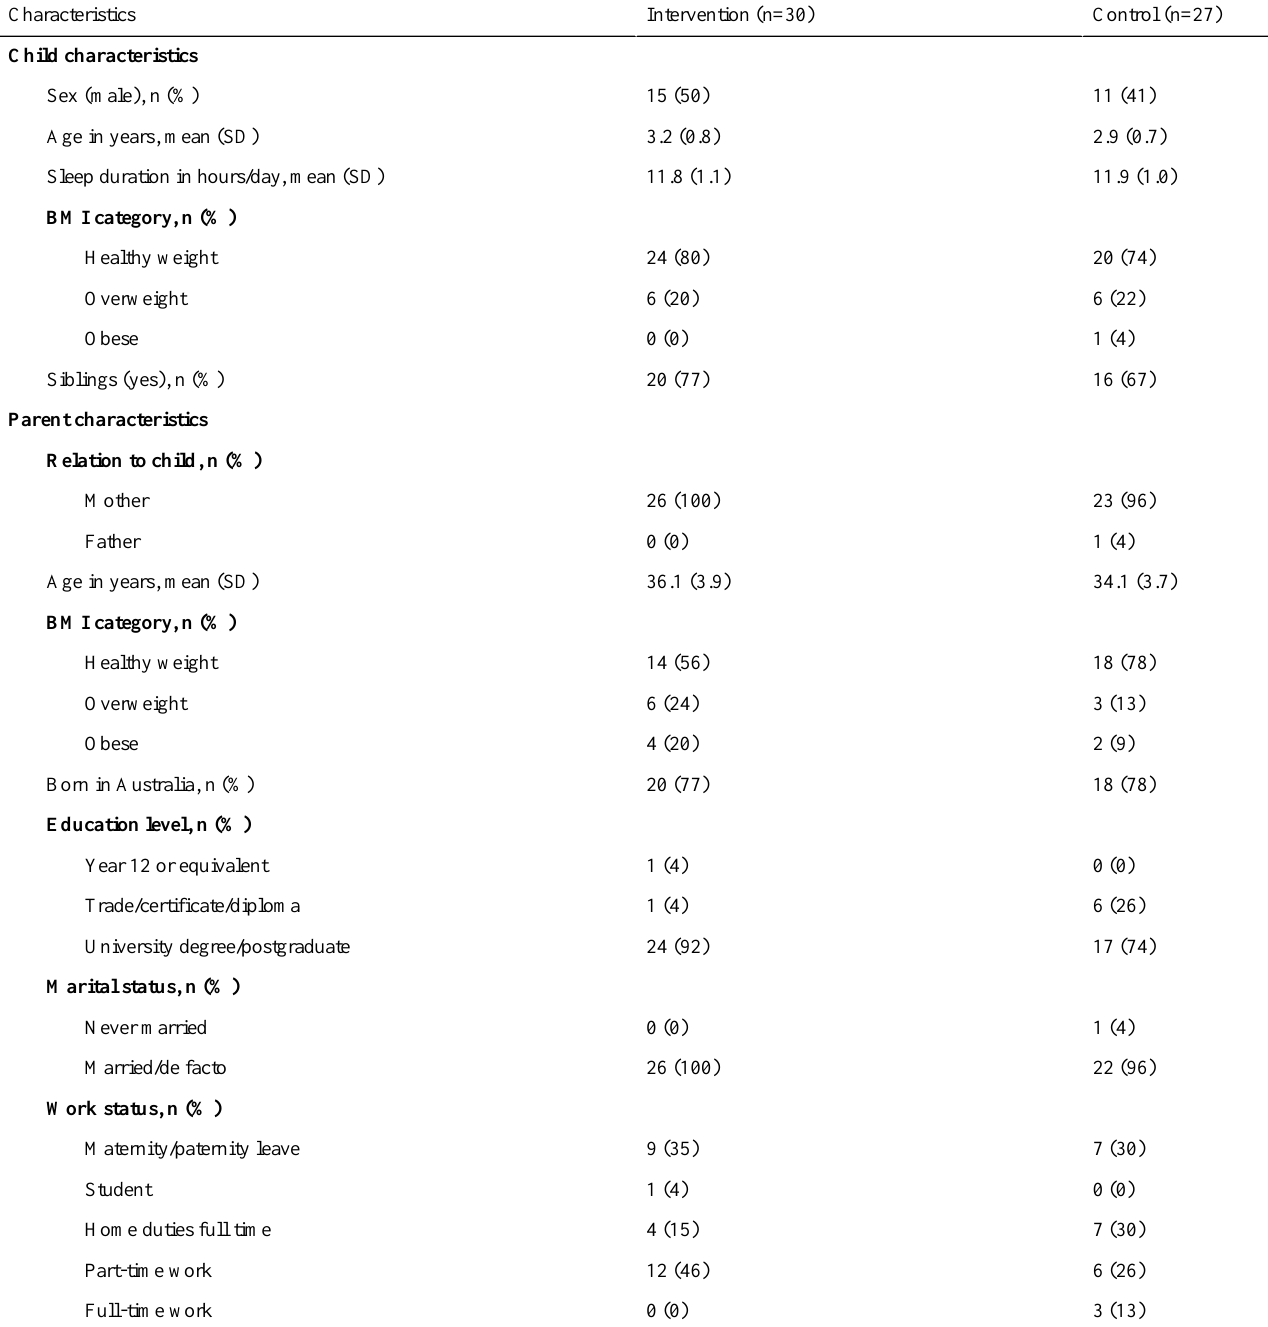
Control (n=27)Intervention (n=30)Characteristics